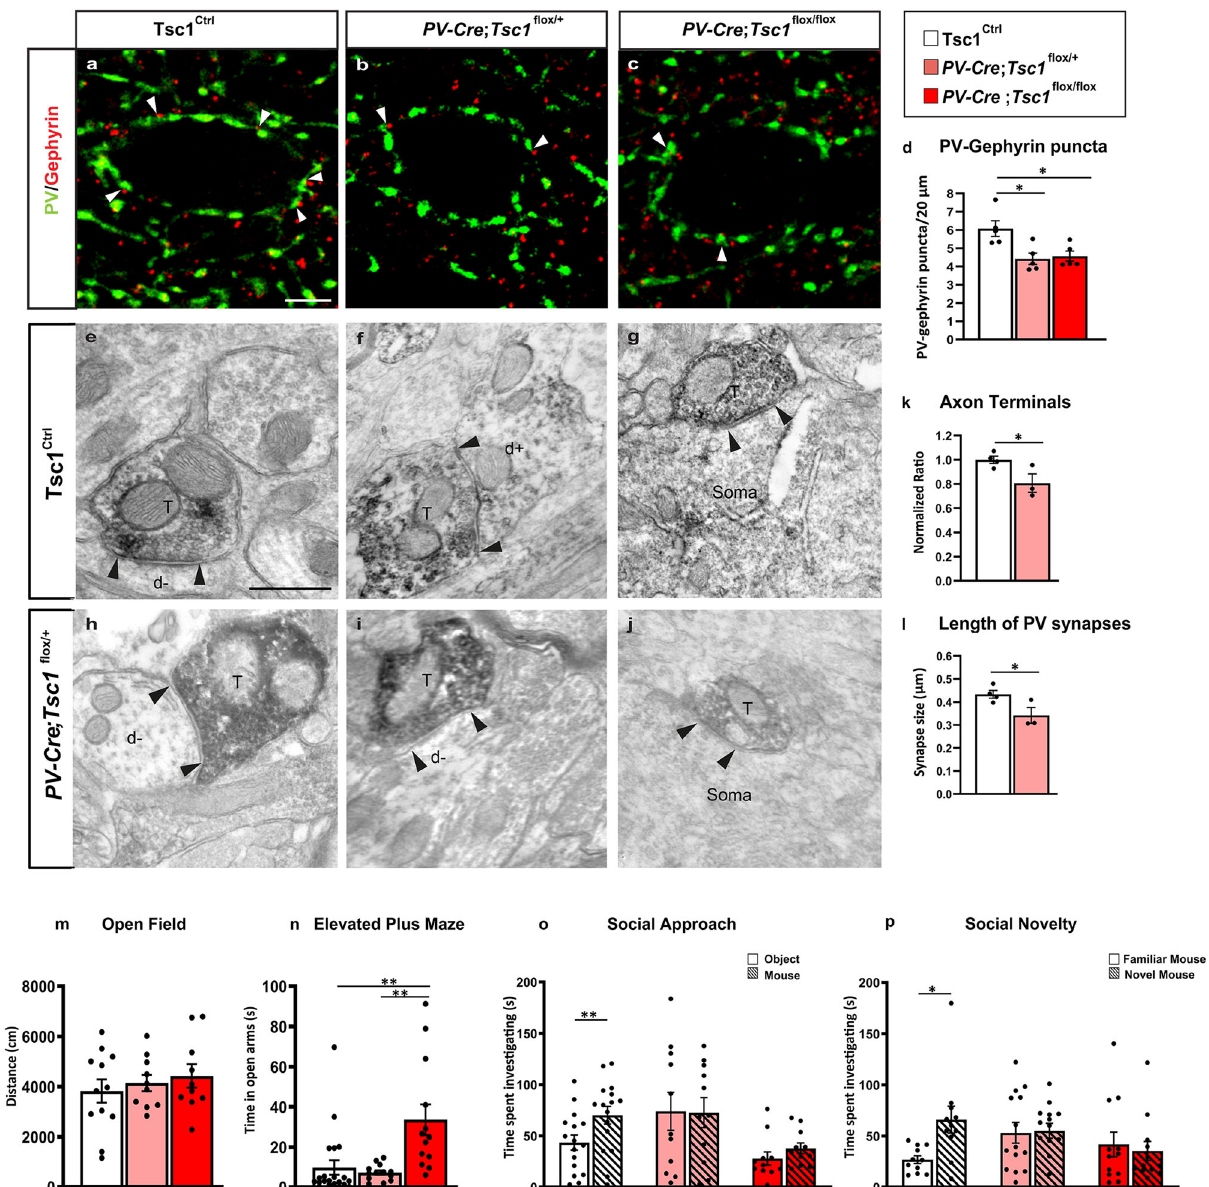
Fig. 2 Tsc1 knockout in PV cells causes PV cell hypo-connectivity and social behavioral de fi cits in young adult mice. a – c Somatosensory cortex coronal sections immunostained for PV (green) and gephyrin (red) from P60 Tsc1 Ctrl ( a ), PV-Cre ; Tsc1 fl ox/ + ( b ), and PV-Cre ; Tsc1 fl ox/ fl ox mice ( c ). White arrowheads indicate PV-gephyrin colocalized boutons. d PV/gephyrin colocalized puncta (one-way ANOVA, * p = 0.0096; Tukey ’ s multiple comparisons test: Tsc1 Ctrl vs PV- Cre ; Tsc1 fl ox/ + * p = 0.0140; Tsc1 Ctrl vs PV-Cre ; Tsc1 fl ox/ fl ox * p = 0.0236), n = 5 mice for all genotypes. Scale bar: 10 µ m. e - j PV-immunolabeled axon terminals in somatosensory cortex of Tsc1 Ctrl ( e , f , g ) and PV-Cre ; Tsc1 fl ox/ + ( h , i , j ) mice. e – g PV + axon terminals (T) make symmetric synaptic contact ( fl anked by arrowheads) with an unlabeled dendritic shaft (d − ). f Rare symmetric synapse between PV + axon terminal and PV + dendrite (d + ). g , j Synaptic contact between a PV + axon terminal (T) and an unlabeled cell soma. k Quanti fi cation of PV + axon terminals in PV-Cre ; Tsc1 fl ox/ + mice (Unpaired t -test, * p = 0.0453). l PV-Cre ; Tsc1 fl ox/ + mice have shorter synapses than Tsc1 Ctrl (Unpaired t test, * p = 0.0464). Number of mice: Tsc1 Ctrl n = 4; PV-Cre ; Tsc1 fl ox/ + n = 3. Scale bars: e – j , 500nm. m Open fi eld test: distance traveled during exploratory activity in an open fi eld arena (one-way ANOVA, p >0.05; Tukey ’ s multiple comparisons test: Tsc1 Ctrl vs PV-Cre ; Tsc1 fl ox/ + p = 0.8537; Tsc1 Ctrl vs PV-Cre ; Tsc1 fl ox/ fl ox p = 0.5794; PV-Cr e; Tsc1 fl ox/ + vs PV-Cre ; Tsc1 fl ox/ fl ox p = 0.8956). Number of mice: Tsc1 Ctrl n = 12; PV-Cre ; Tsc1 fl ox/ + n = 10; PV-Cre ; Tsc1 fl ox/ fl ox n = 10. n Elevated plus maze: Quanti fi cation of time spent in the open arms of elevated plus maze arena (one- way ANOVA, *** p = 0.0006; Tukey ’ s multiple comparisons test: Tsc1 Ctrl vs PV-Cre ; Tsc1 fl ox/ + p = 0.9205; Tsc1 Ctrl vs PV-Cre ; Tsc1 fl ox/ fl ox ** p = 0.0017 ; PV-Cre ; Tsc1 fl ox/ + vs PV-Cre ; Tsc1 fl ox/ fl ox ** p = 0.0018) . Number of mice: Tsc1 Ctrl n = 21; PV-Cre ; Tsc1 fl ox/ + n = 13; PV-Cre ; Tsc1 fl ox/ fl ox n = 13. o , p Unlike Tsc1 Ctrl mice, both PV- Cre ; Tsc1 fl ox/ + and PV-Cre ; Tsc1 fl ox/ fl ox mice failed to show preference for a mouse vs an object ( o ) (two-way ANOVA, F = 3.968 p = 0.0280, F genotype (2, 35) time (1, 35) = 4.593 p = 0.0391, F genotype*time (2, 35) = 2.376 p = 0.1077; ** p = 0.0089, Sidak ’ s multiple comparisons test) or for a novel mouse vs a familiar one ( p ) (two-way ANOVA, F genotype (2, 34) = 1.108 p = 0.3418, F time (1, 34) = 2.640 p = 0.1134, F genotype*time (2, 34) = 3.615 p = 0.0377; * p = 0.0147, Sidak ’ s multiple comparisons test); Number of mice: o Tsc 1 Ctrl n = 16; PV-Cre ; Tsc1 fl ox/ + n = 11; PV-Cre ; Tsc1 fl ox/ fl ox n = 11. p Tsc1 Ctrl n = 11; PV-Cre ; Tsc1 fl ox/ + n = 14; PV-Cre ; Tsc1 fl ox/ fl ox n = 12. Data represent mean±SEM. Source data are provided as a Source Data fi